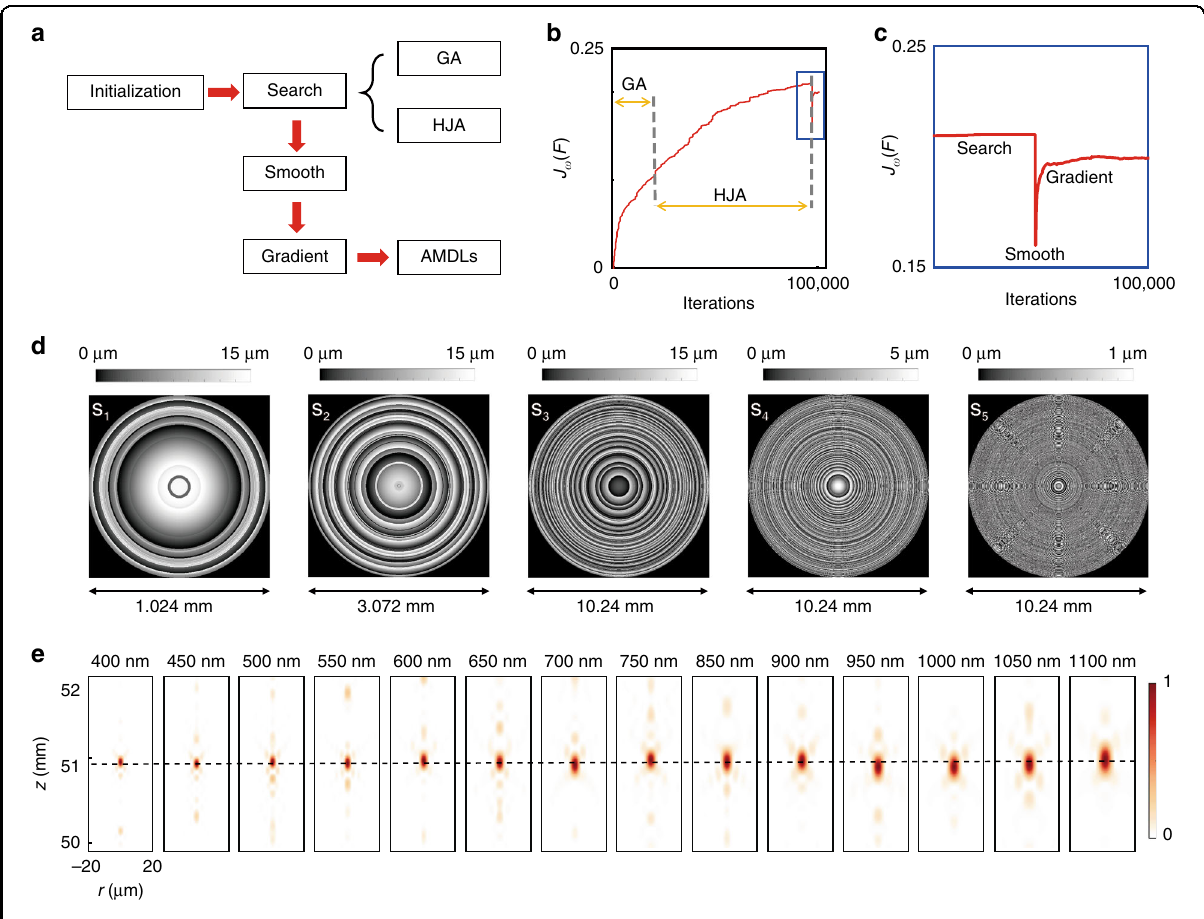
Fig. 2 Design and theoretical results of AMDLs. a The schematic of the optimization framework. b The change of J ω ( F ) over the course of the optimization process. Before the sharp dip is the Search operation, where GA and HJA are applied in turn. c The details around the sharp dip in b . The sharp dip is caused by the Smooth operation. d Height distribution (2D top view) of samples S 1 -S 5 . e Calculated light intensity pro fi les along propagation axis for sample S